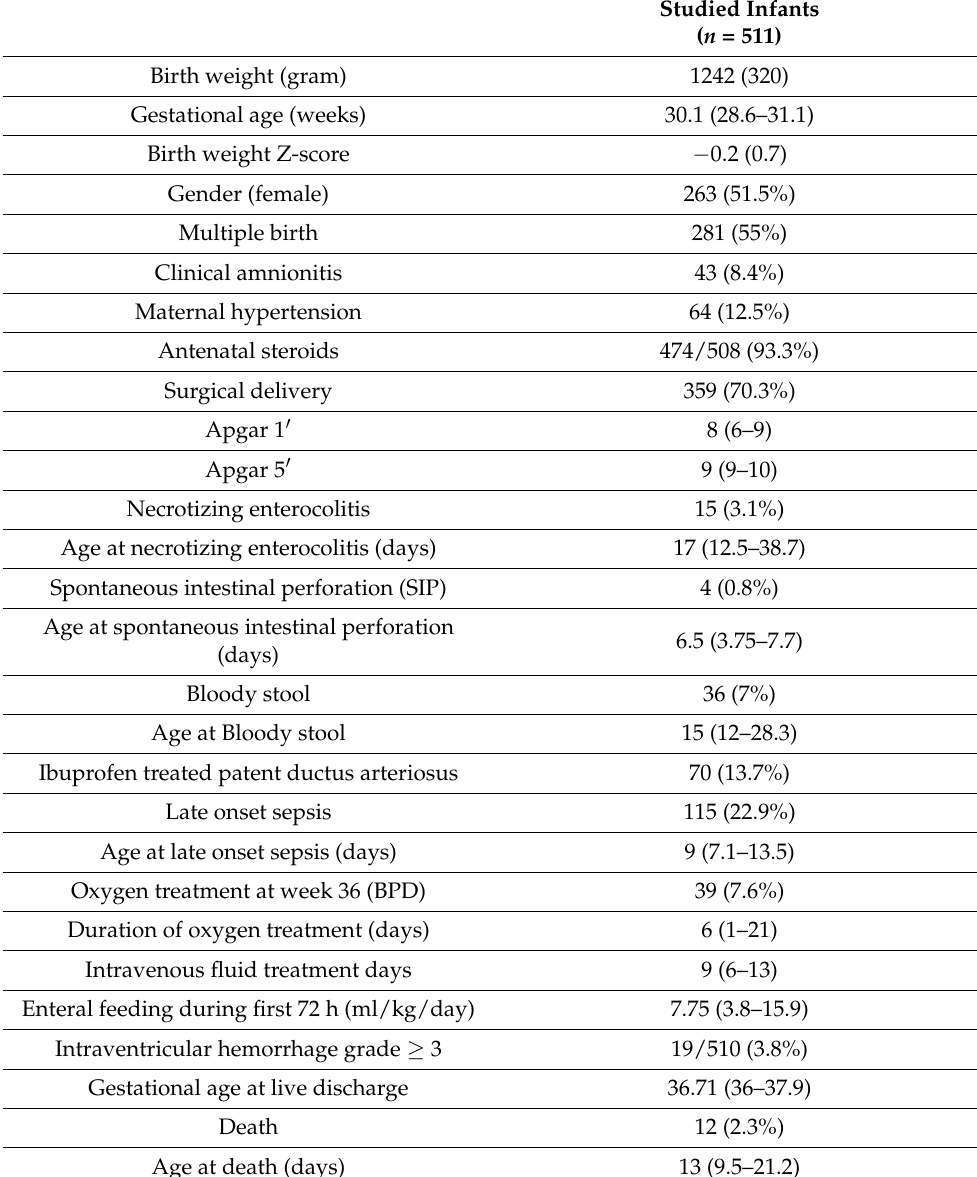
Table 2. Clinical characteristics of included infants. (Israel, 2012–2017).